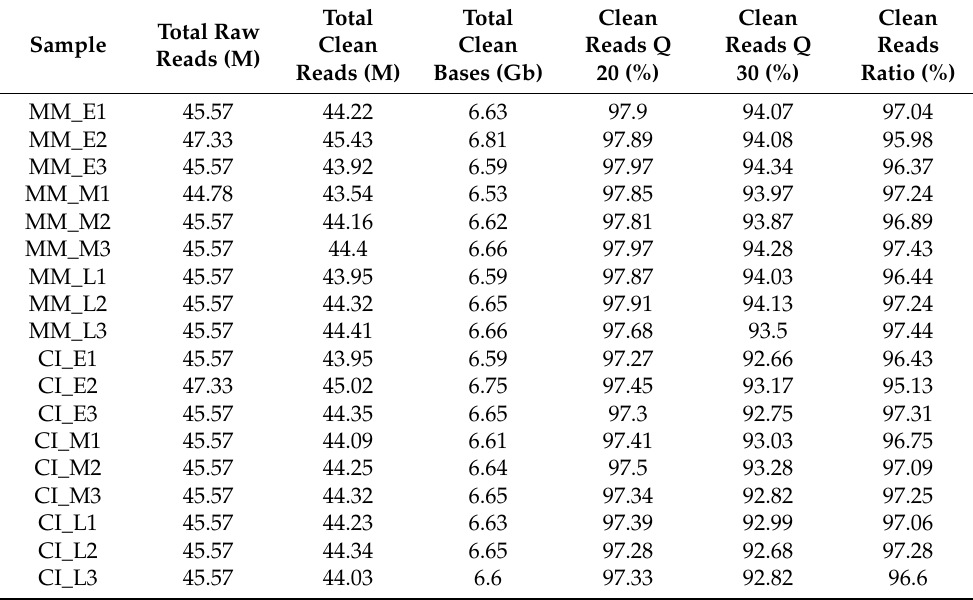
Table 1. Statistics of the tomato transcriptome